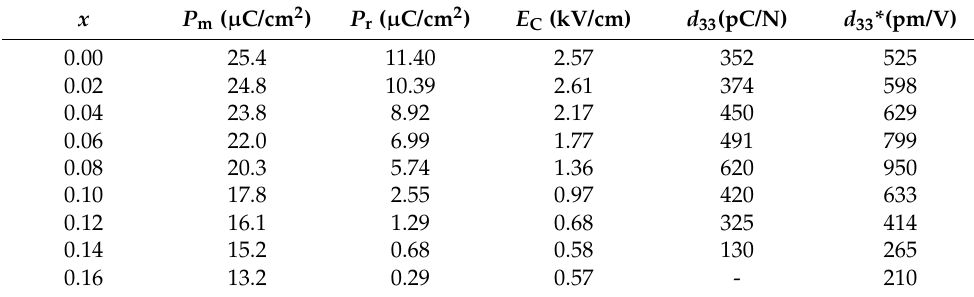
Table 2. Ferroelectric and piezoelectric properties of BT- x CS